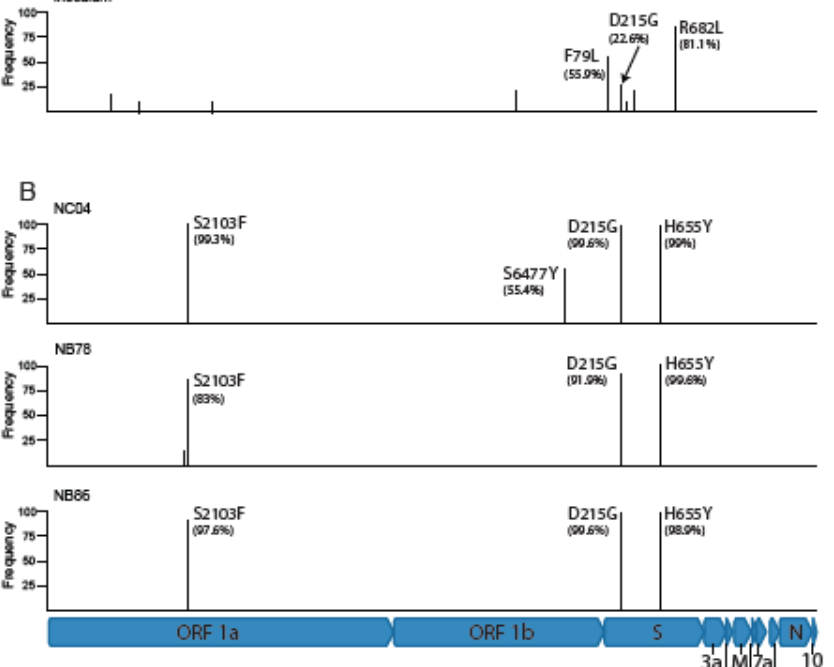
Figure 1. Viral evolution detected in rectal swabs in SARS-CoV-2 infected AGM. ( A ) AGMs were challenged via an intranasal and intratracheal route with SARS-CoV-2 using a stock of the WA1/2020 isolate harboring several variants relative to the patient sample. ( B ) Sequencing of viral RNA isolated from rectal swabs at 3–4 weeks after challenge revealed a consistent pattern of variants in all three animals. ( C ) Two spike mutations detected in all animals map to the N-terminal domain (D215G) and near the furin cleavage site (H655Y) based on a spike structure (PBD 7K8Z [26]).